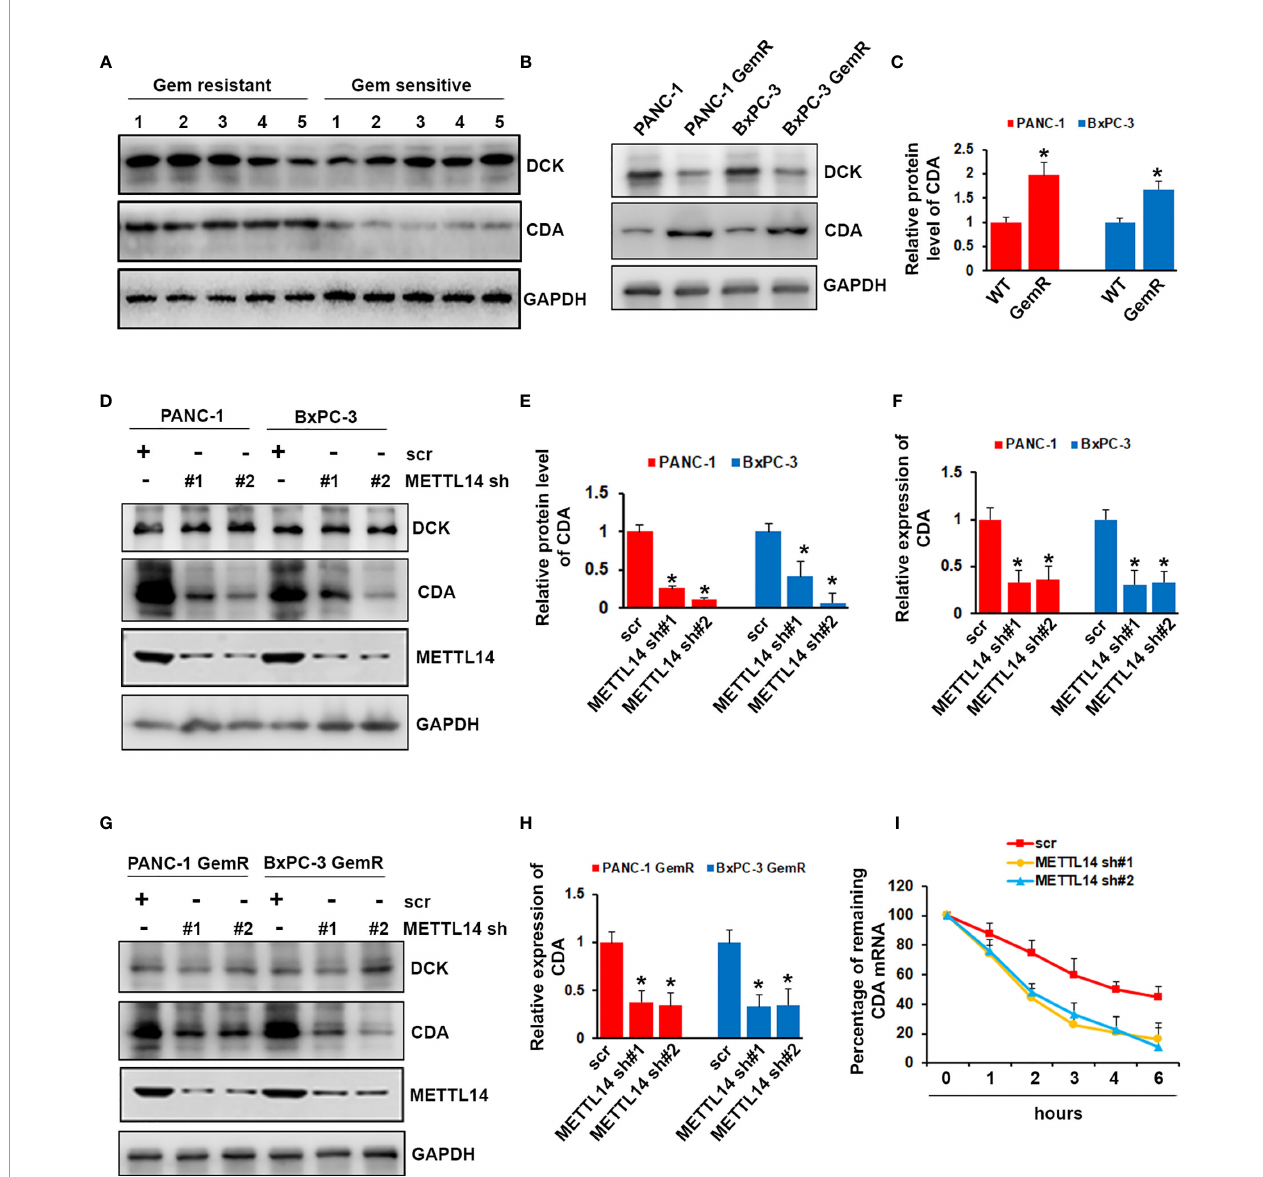
FIGURE 5 | Effect of METTL14 on regulating cytidine deaminase (CDA) expression. (A) The protein level of DCK and CDA in gemcitabine resistant or sensitive tumors (n=5) was assessed by western blotting. (B, C) The protein level of DCK and CDA in PANC-1 GemR/BxPC-3 GemR and their parental wild type cells was assessed by western blotting. Data are reported as means ± SEM of values from three experiments. *p < 0.05. (D – F) The protein (D, E) and mRNA (F) level of CDA was assessed by western blotting and QRT-PCR after METTL14 depletion in PANC-1 and BxPC-3 cells. Data are reported as means ± SEM of values from three experiments. *p < 0.05. (G, H) The protein (G) and mRNA (H) level of CDA was assessed by western blotting and QRT-PCR after METTL14 depletion in PANC-1 GemR and BxPC-3 GemR cells. Data are reported as means ± SEM of values from three experiments. *p < 0.05. (I) QRT-PCR analysis of CDA mRNA levels in PANC-1 cells (scr or METTL14 shRNA) after actinomycin D